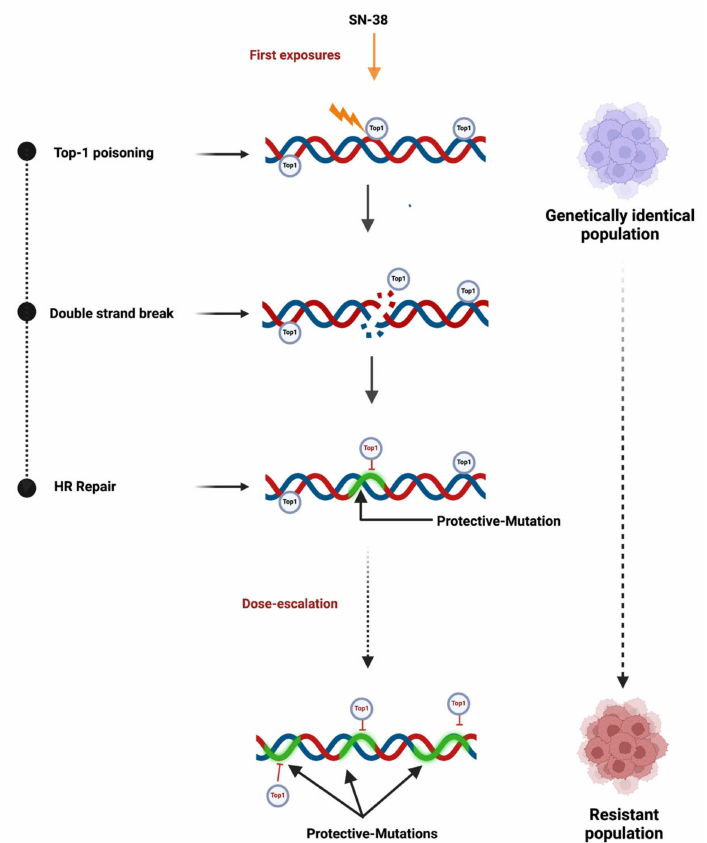
Figure 4. Study model for dose escalation-mediated drug resistance. Resistance mutations result from cycles of creating DSB and their repair at the Top1-binding